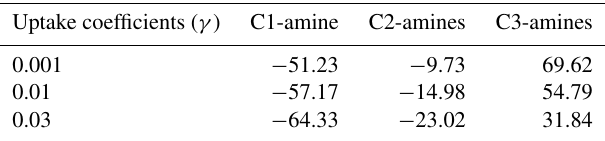
Beijing time Figure 9. Time series of observed and simulated concentrations of C1-, C2-, and C3-amines with γ = 0 . 001, 0.01, and 0.03 from 25 to 31 July 2015 at the Fudan site. Table 6. Variations in normalized mean biases (NMBs) of methylamines simulations when aerosol uptake coefficients is 0.001, 0.01, and 0.03 at the Fudan site in domain 4 during period from 25 and 31 July